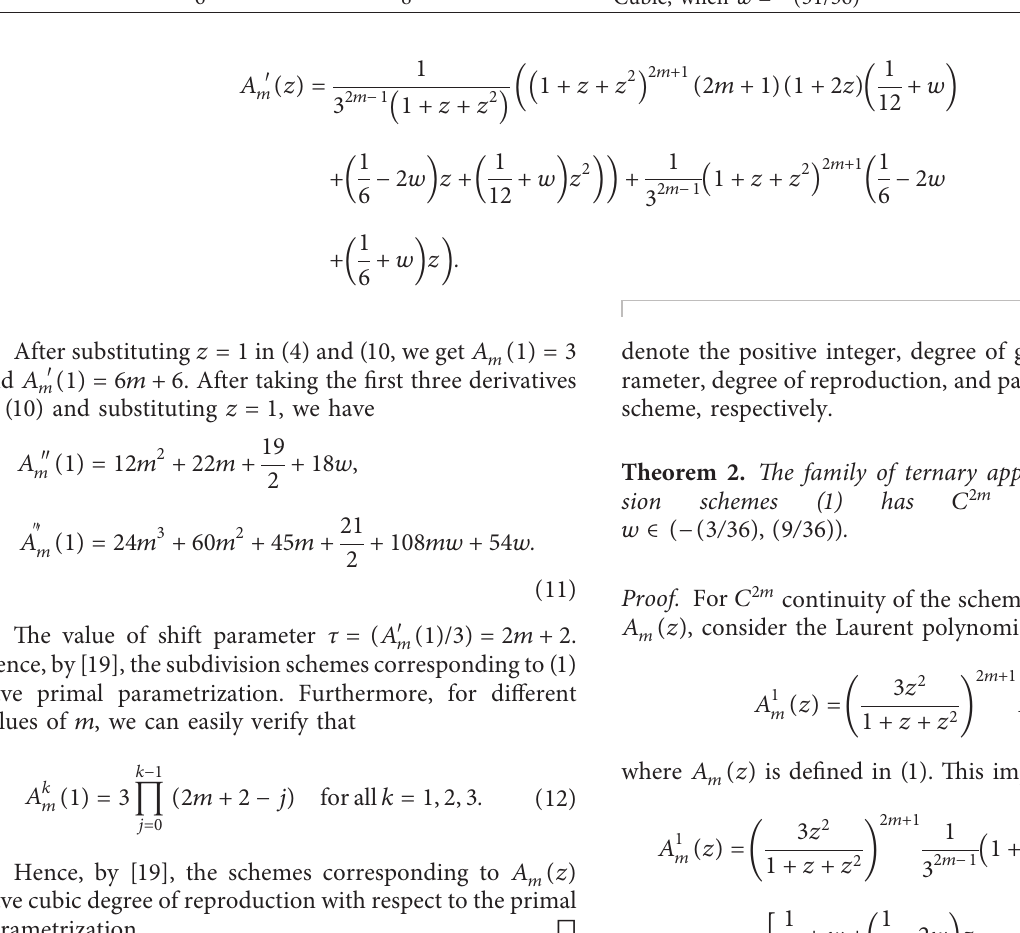
Table 3: The degree of generation and degree of reproduction w.r.t parameterization for different values of m . m G R d τ d Parameterization 1 2 4 Quadratic, when w � − ( 5/12 ) Primal 2 4 6 Cubic, when w � − ( 23/36 ) Primal 3 Cubic, when w � − ( 31/36 )